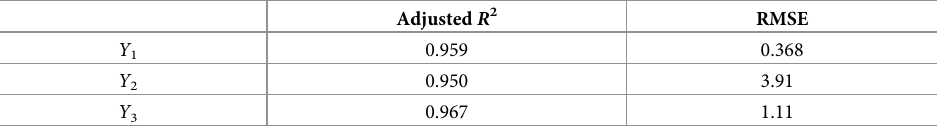
Table 9. Adjusted R 2 and RMSE values for Model C-Accelerated. Y 1 , Y 2 , and Y 3 are Δ E , Δ Gloss 60 , and Δ Haze ,